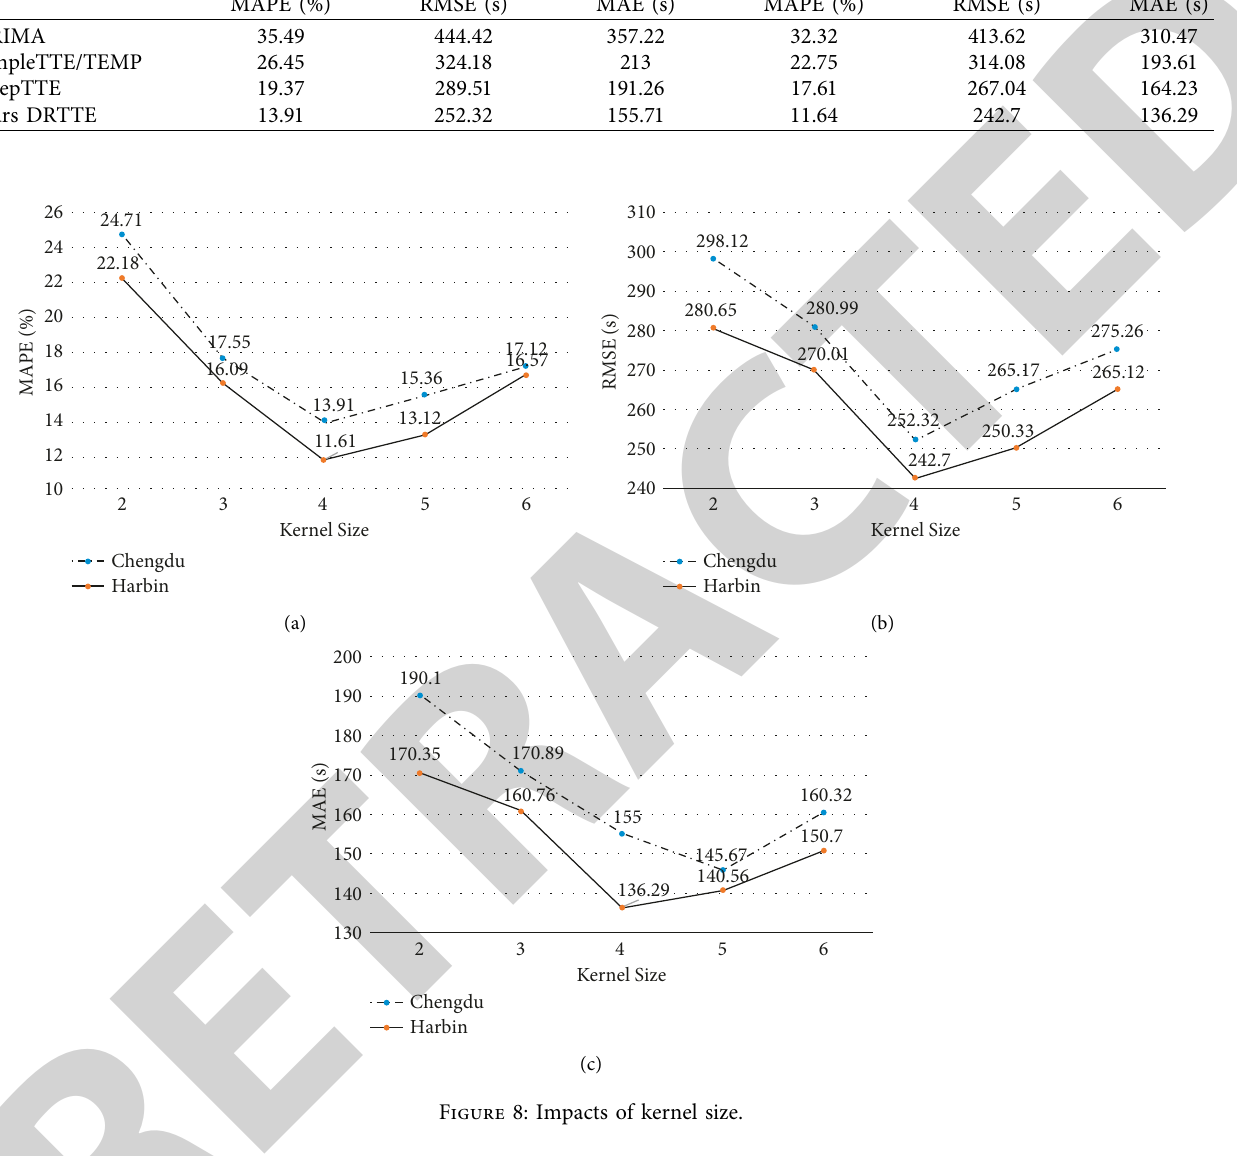
Figure 8: Impacts of kernel